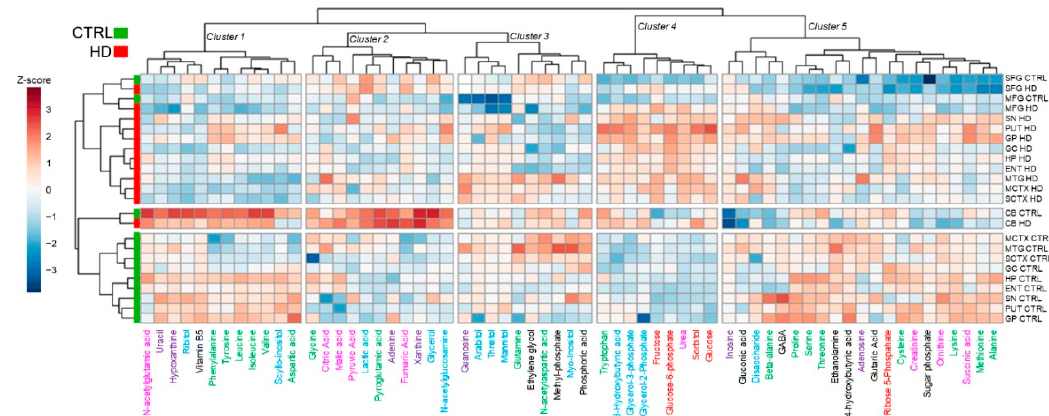
Figure 3. Analysis by hierarchical clustering of metabolite abundances in control and HD brain. This shows substantial separation between controls (green) and HD cases (red) across brain regions. Of interest, the most significant clustering is present in cluster 4 ( p = 7.57 × 10 − 5 , FDR-corr), which is primarily enriched by categories of metabolites as alternative fuel sources, sugars, and urea. The Euclidean distance method was used for hierarchical clustering; values are expressed as Z-scores and visually represented as a colour-gradient scale.